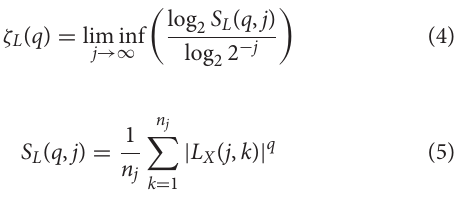
the structure of data X via spectrum data. The discrete